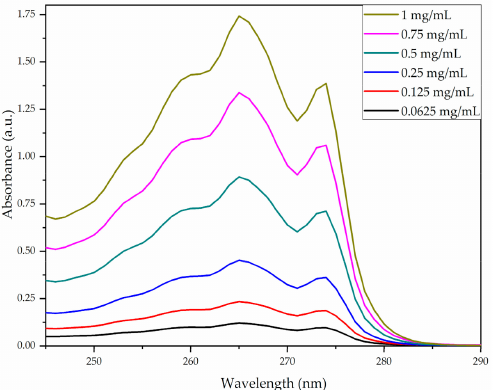
Figure 1. UV-Vis spectrograms of Ibuprofen solutions.